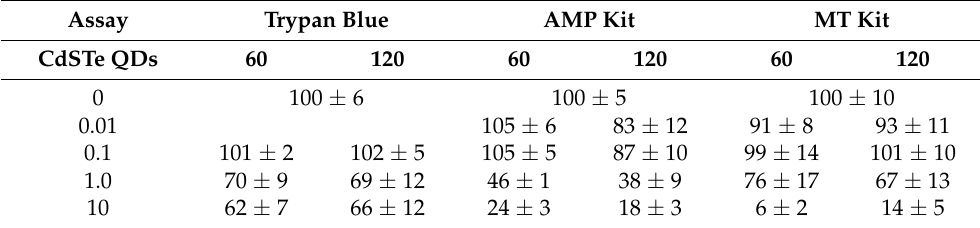
Table 1. Viability of CHO-K1 cells determined using trypan blue, CellTiter-Glo ® luminescent (AMP kit), and RealTime-Glo™ MT (MT kit) assays exposed for 24 h to CdSTe QDs synthesized at 60 and 120 °C (concentrations between 0.01 and 10 mg/L).